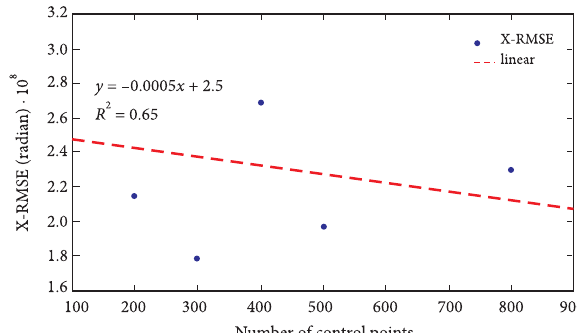
Fig. 7. RMSE (Longitude) changing rate by increasing control